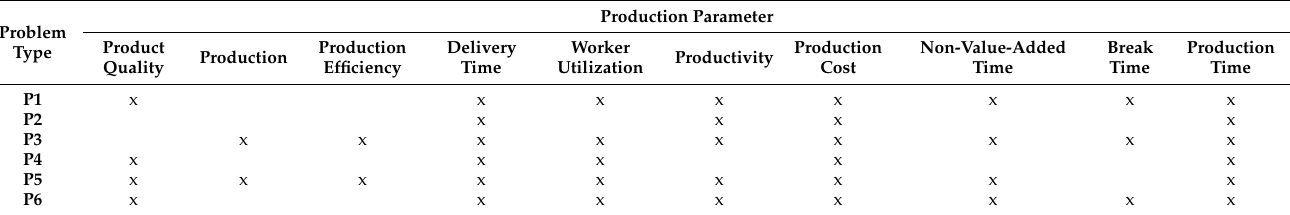
Table 4. Production parameters affected due to problems.